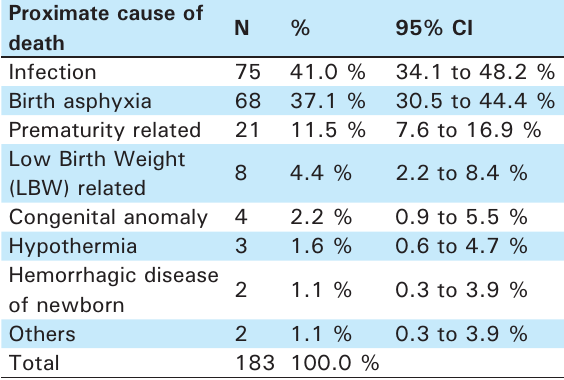
Table 1: Proximate cause of death in newborns as